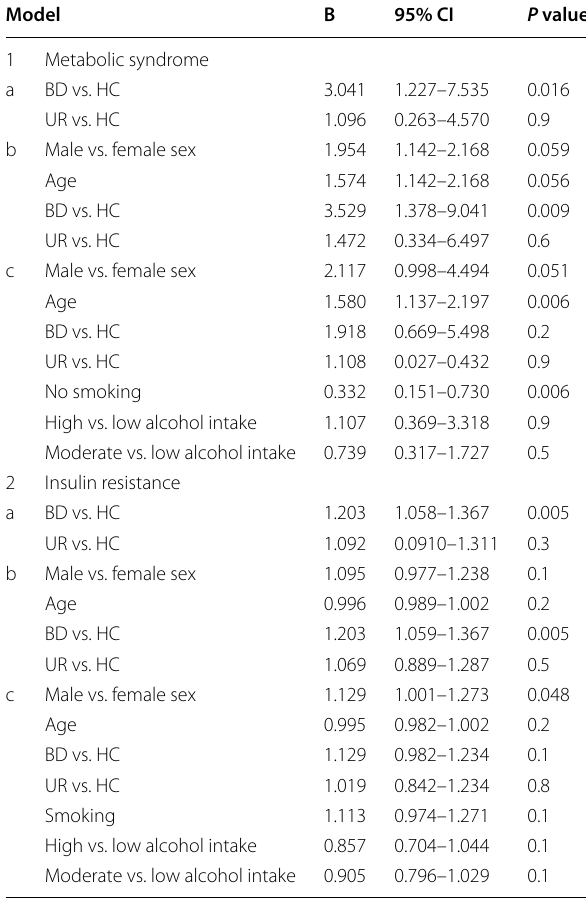
Table 2 Metabolic syndrome and insulin resistance in patients with bipolar disorder (BD) and their unaffected first-degree relatives (UR) compared with healthy individuals